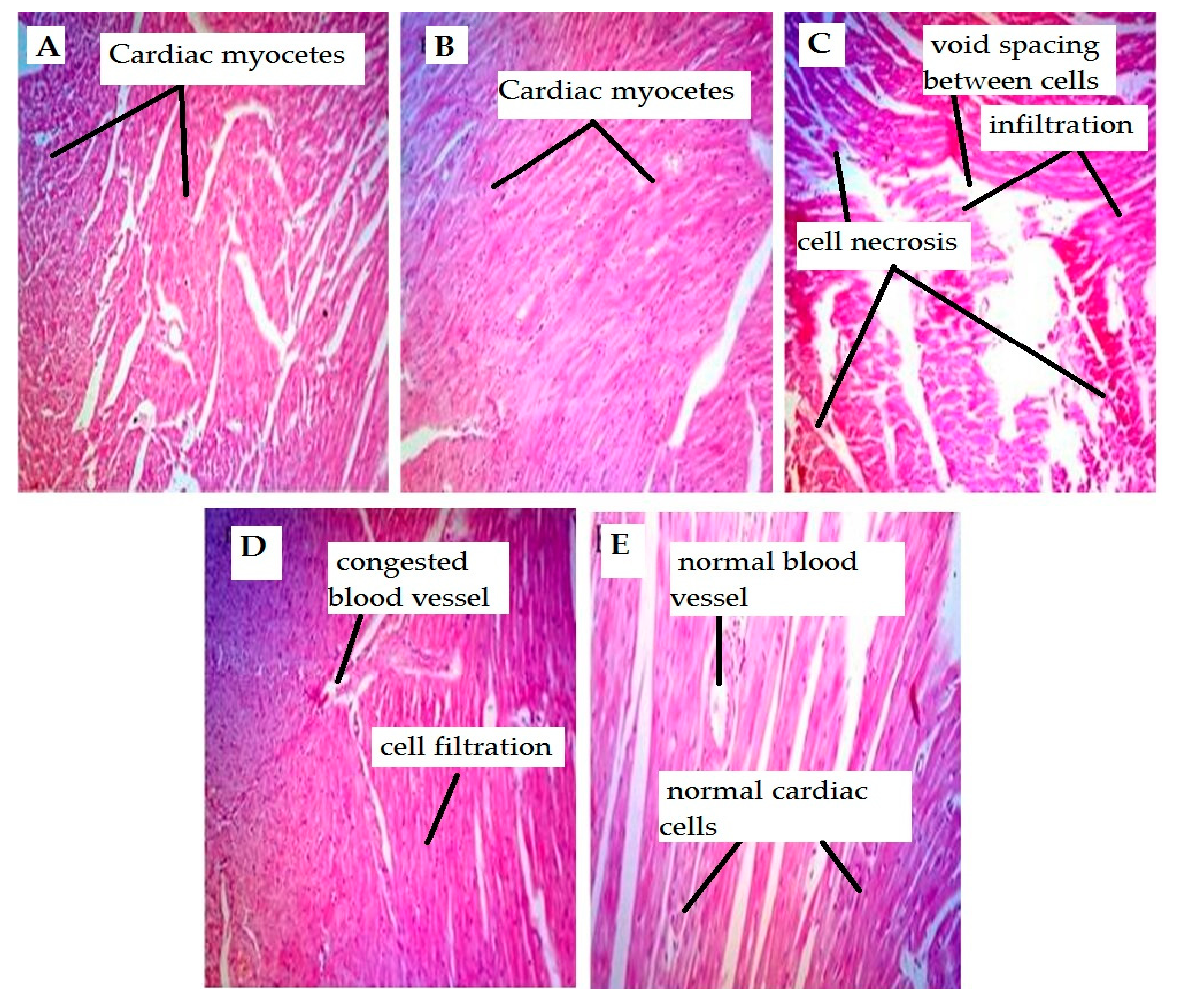
Figure 1. Histopathological changes induced by 5-fluorouracill and protective effect of test com- pounds in rat’s heart. ( A ) Cardiac section of rats belongs to control group (normal saline) showing normal morphology. ( B ) Cardiac sections from 5-fluorouracill + atenolol-treated rats revealed normal morphology with mild cellular infiltration. ( C ) Depicted a cardiac section of rats treated with 5-fluorouracill alone showing a damaged area with staining and cellular infiltration. ( D ) 5-Fluorouracill+ Comp-1 (5 mg/kg I.P) showed a reduction in degenerations. ( E ) 5-Fluorouracill + Comp-1 (10 mg/kg I.P)-treated group results in significant protection against cardiac injury caused by 5-fluorouracill. (Fixed in a 10% buffered neutral formalin solution stained with hematoxylin and eosin (H&E), magnifications power 10×.)